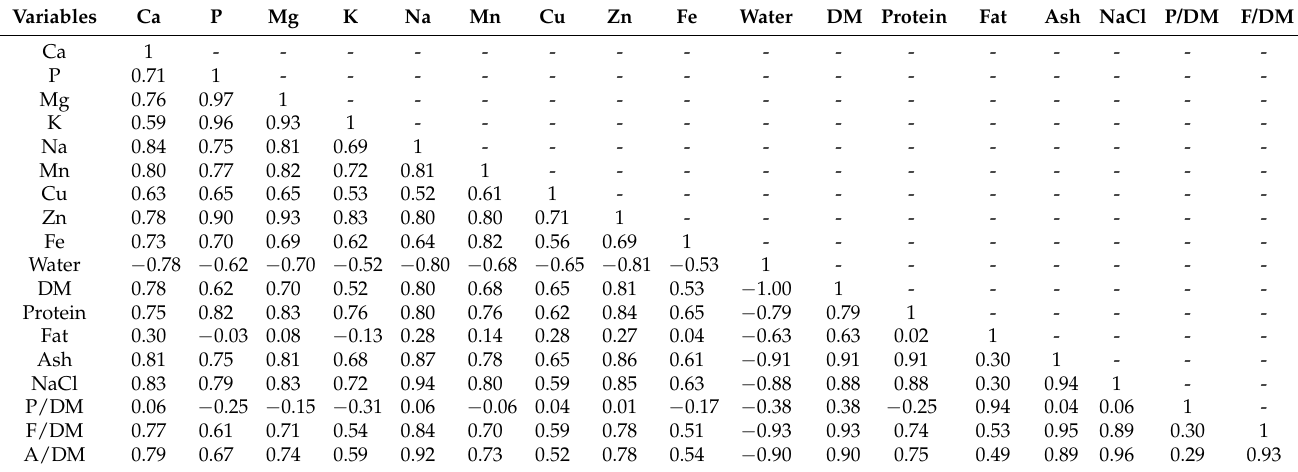
Table 2. Pearson correlation matrix (n) of the investigated